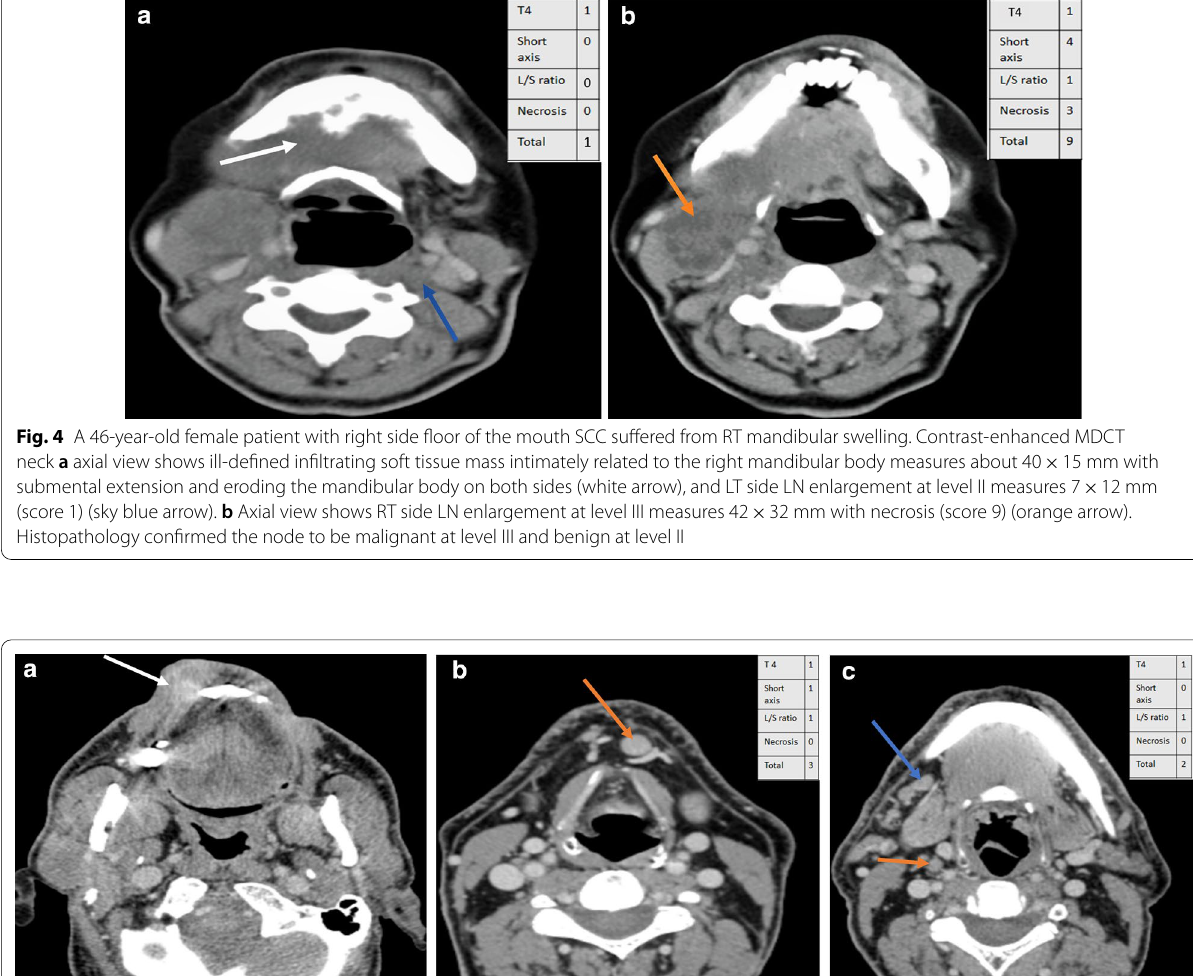
Fig. 5 A 64-year-old male with lower lip SCC patient suffered from painful bleeding red and white patch on the lip. Contrast-enhanced MDCT neck a axial view shows lower lip faintly enhanced soft tissue mass measures 54 49 mm (white arrow). b Axial view shows LT side LN enlargement at × level IA measures 10 10 mm (score 3) (orange arrow). c Axial view shows RT side LN enlargement at level IB measures 5 7 mm (score 2) (sky blue × × arrow) and RT side LN enlargement at level IIA measures 5 7 mm (score 2) (orange arrow). Histopathology confirmed the node to be malignant at × level IA and benign at level IB &